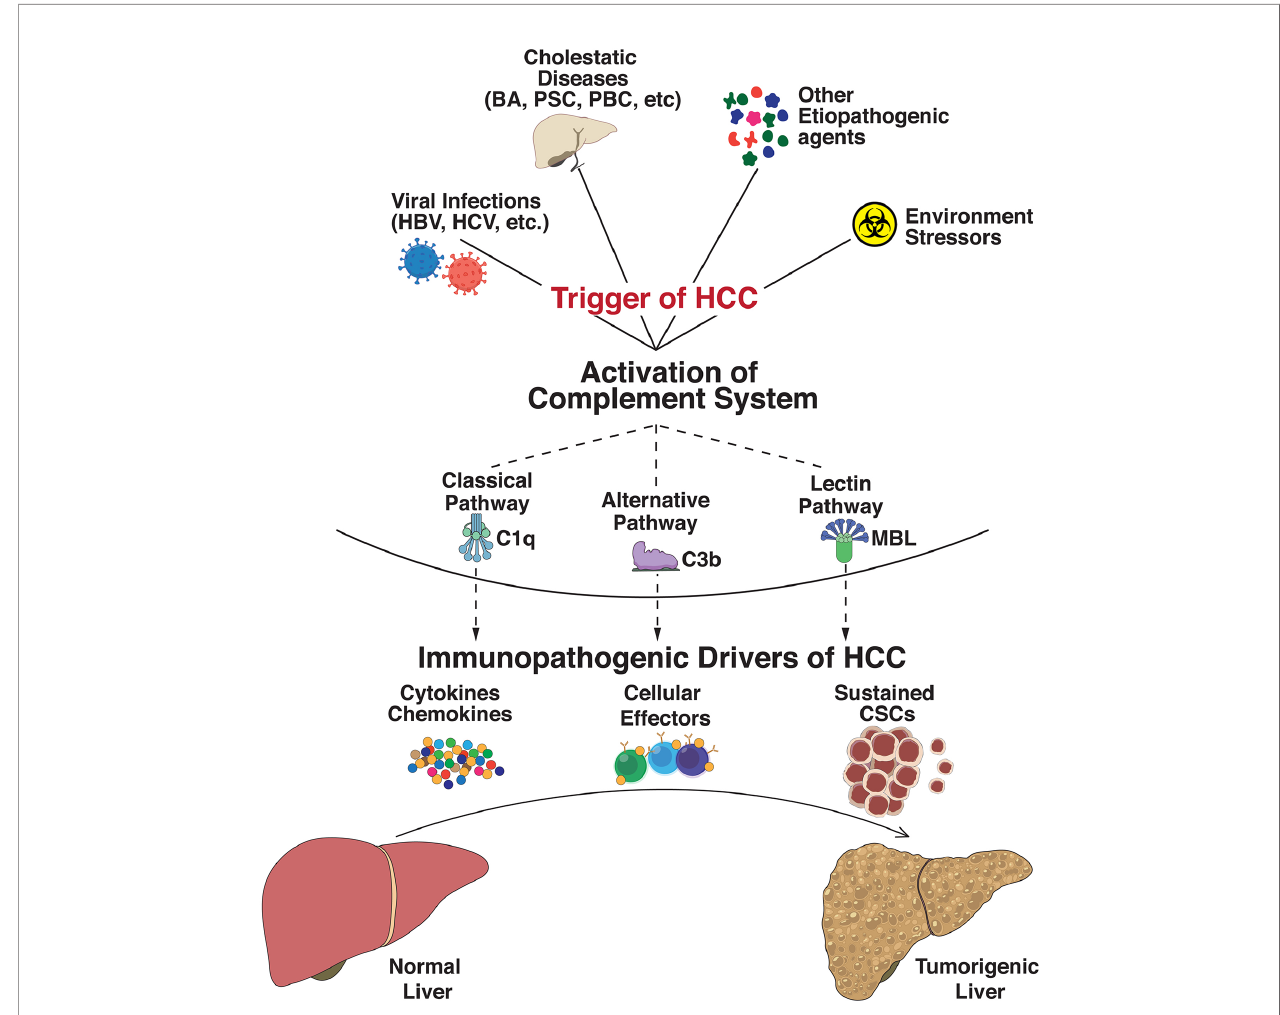
FIGURE 1 | Immunopathogenic complement activation regulates progression to hepatocellular carcinoma. Exposure of the hepatic milieu to several triggers linked either to viral infections (Hepatitis B virus, Hepatitis C virus, etc.), severe obstructive and cholestatic diseases (Biliary atresia, Primary Sclerosing Cholangitis, Primary Biliary Cirrhosis, etc.), environmental stressors/toxin exposures (polychlorinated biphenyls, arsenic, androgenic steroids, etc.), and other etiopathogenic agents (a fl atoxins, oral contraceptives, vinyl chloride, etc.) dictate the evolution of hepatocellular carcinoma (HCC). These triggers activate the innate immune complement cascade via classical (involving C1q complex), alternative (C3b-dependent activation), or lectin (triggered by carbohydrates) pathways. Abnormal activation of these complement pathways modulates functional effects of intrahepatic immune and epithelial cell compartments and disseminates signi fi cant perturbation of effector innate and adaptive cells, cytokine and chemokine expressions, and sustained cancer stem cell (CSC) activities. The collective net result of these processes de fi nes the progression of HCC